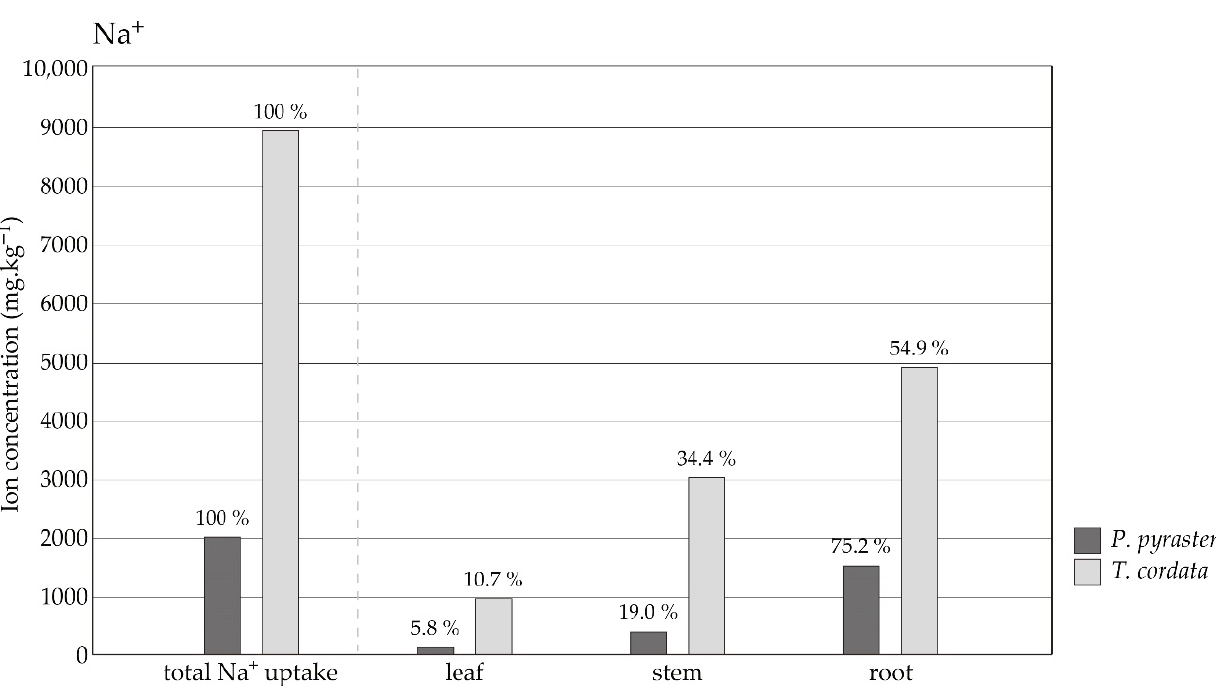
Figure 6. The content and distribution of Na+ ions in the plant tissues (leaves, stem, roots) of P. pyraster and T. cordata seedlings grown for 50 days under salt treatment with 100 mM NaCl solution. The values above the bars indicate distribution to the plant organs as a percentage of the total Na+ ion uptake.